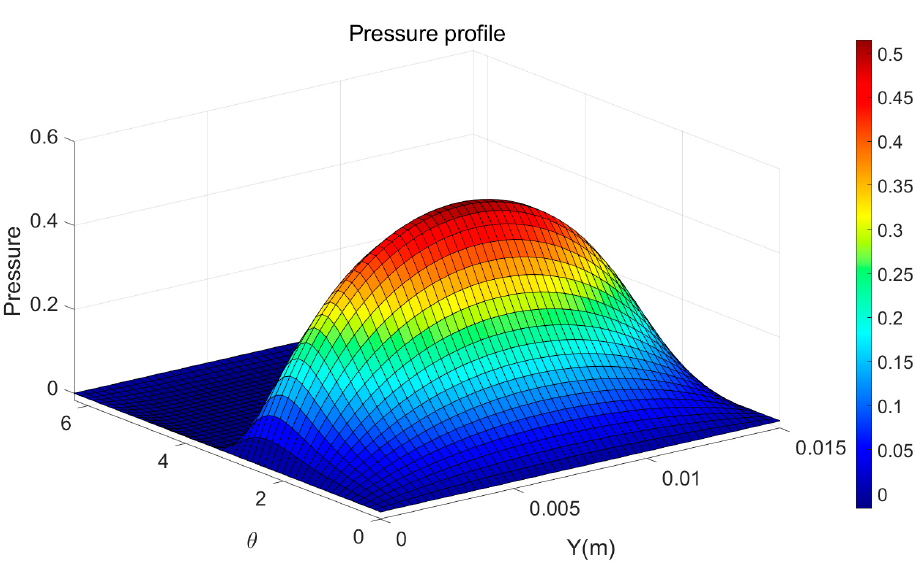
Figure 7. Reynolds equation calculation results .